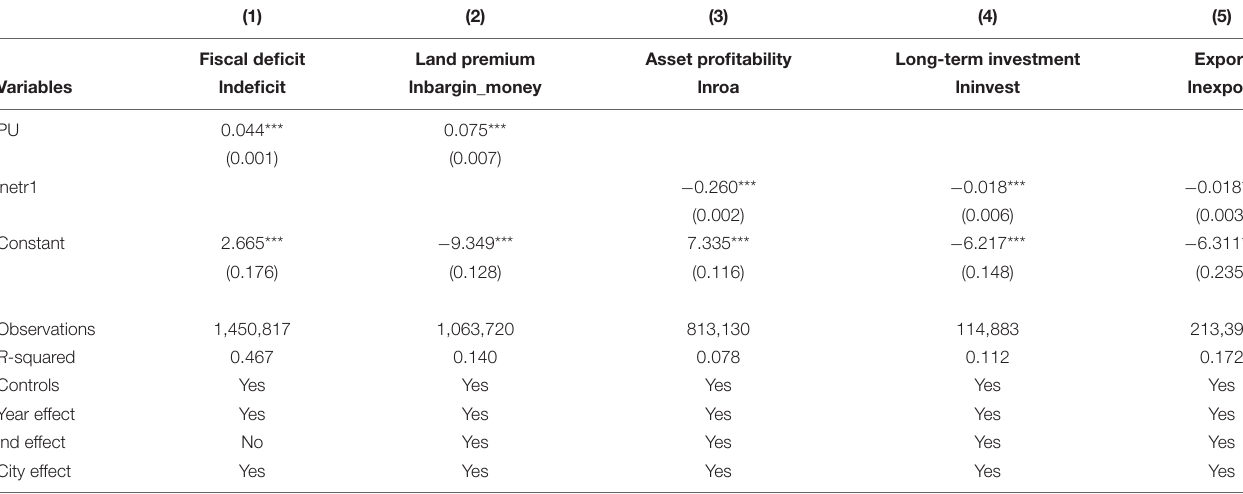
TABLE 9 | Impact of official assignment on local fiscal